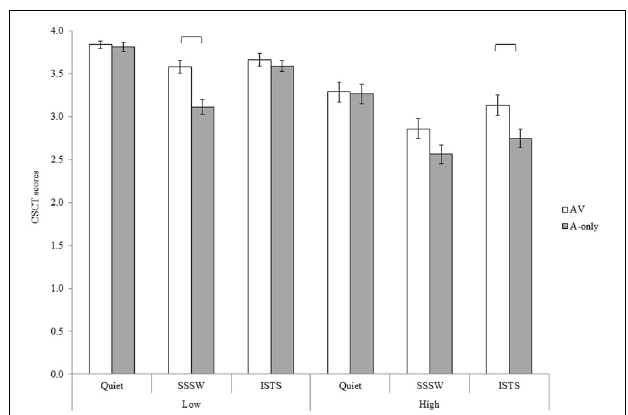
FIGURE 4 | Three-Way interaction between memory load, modality, and noise for CSCT scores collapsed across groups of participants and the executive task performed. Error bars represent standard